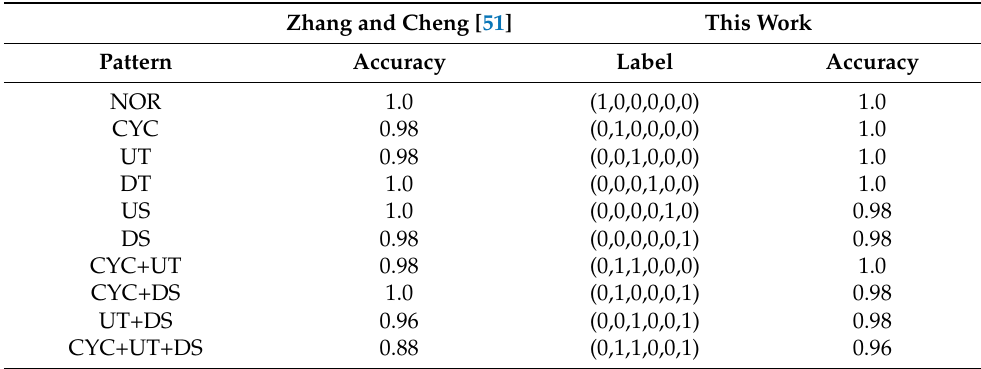
Table 5. A detailed comparison between the proposed multi-label CNN and the feature-based SVC developed by Zhang and Cheng [51]. Zhang and Cheng [51] This Work Pattern Accuracy